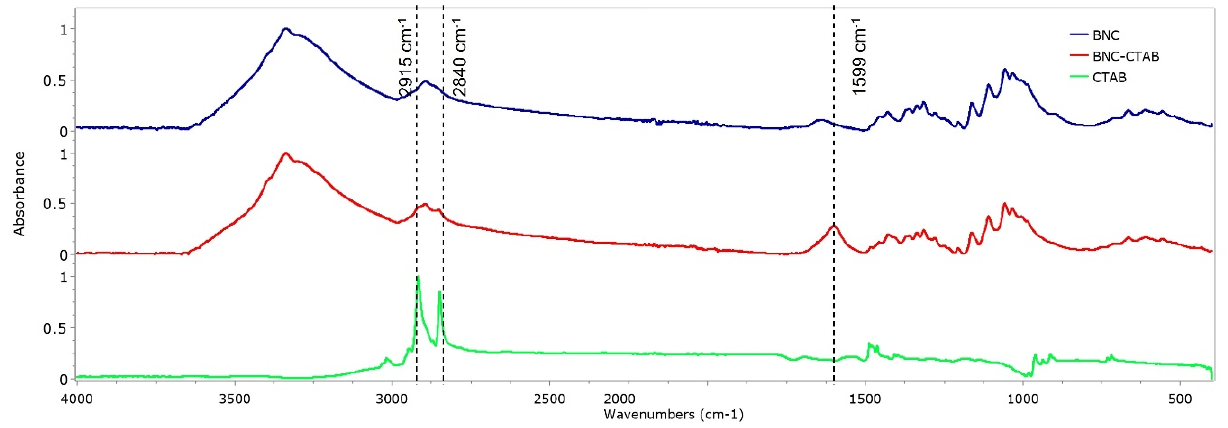
Figure 4. FTIR spectrum of BNC, BNC-CTAB, and free CTAB.